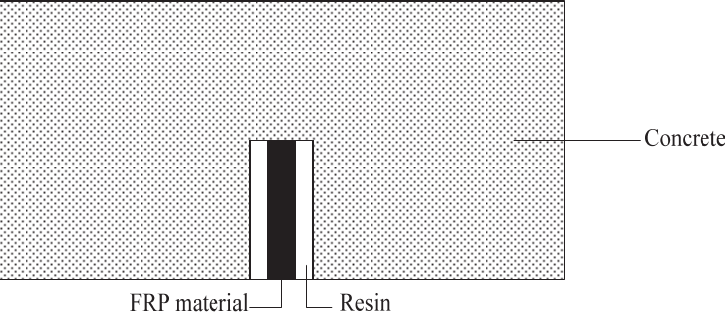
Figure 1: The schematic diagram of embedded